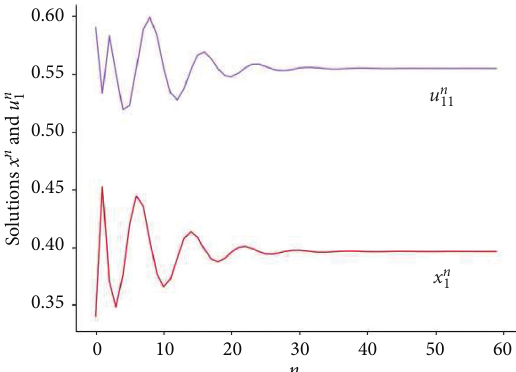
Figure 2: Dynamic behaviors of x n